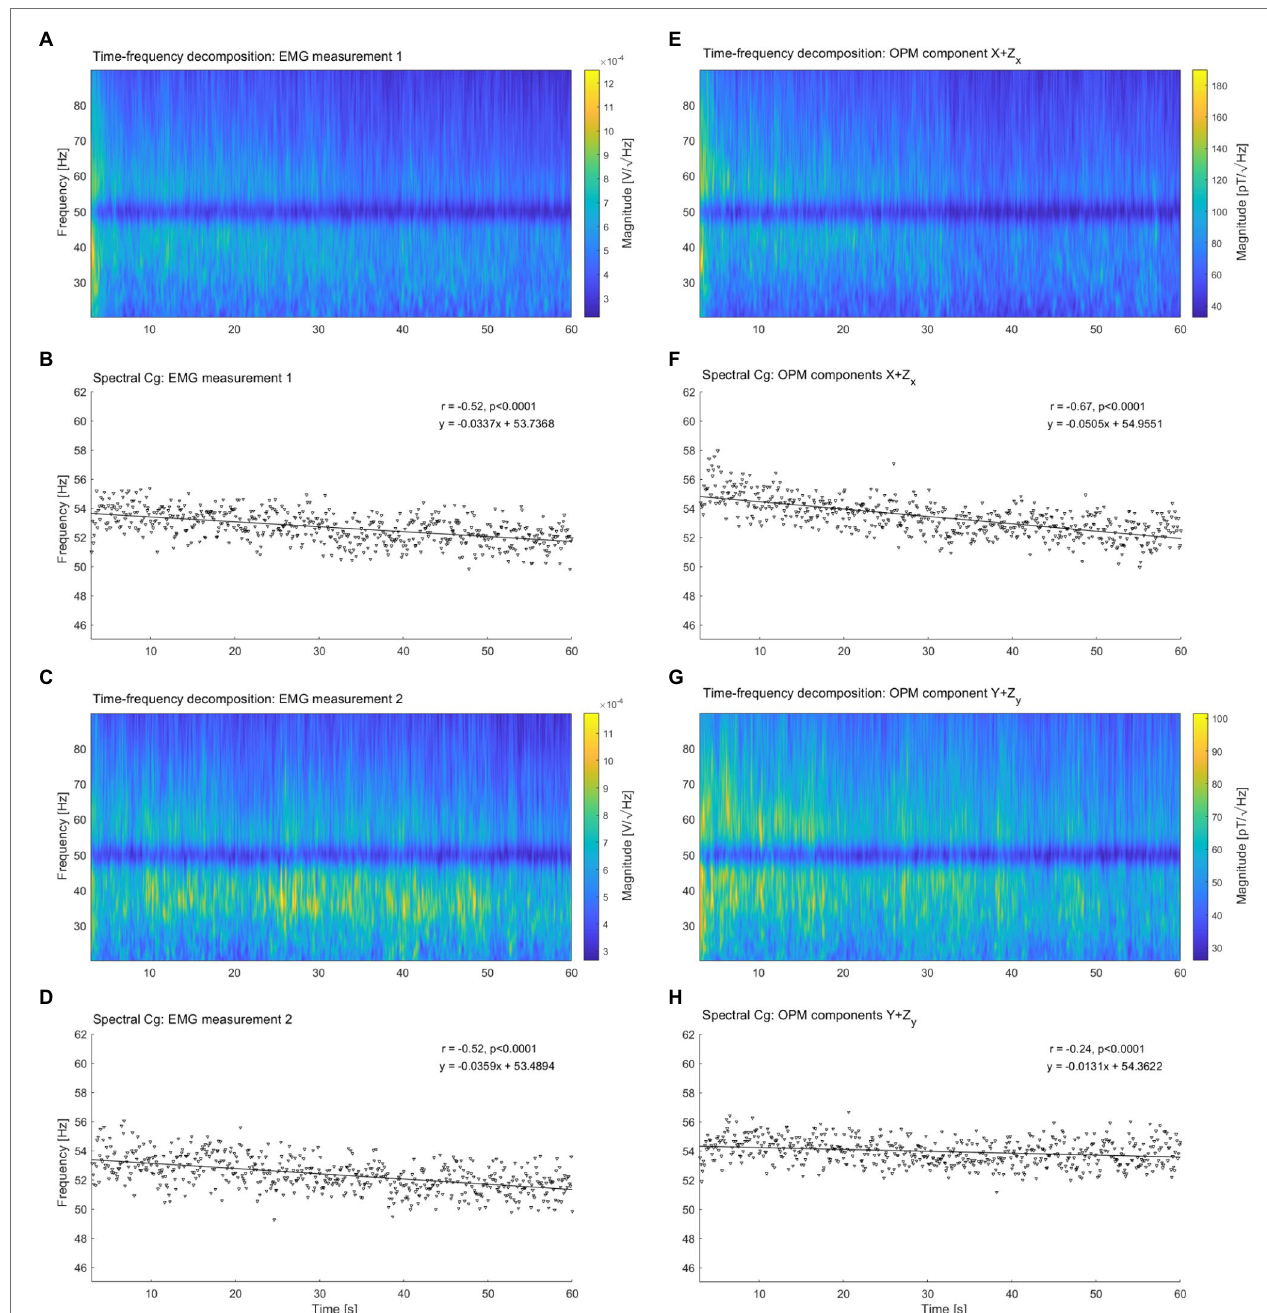
FIGURE 3 | Spectral decomposition and spectral center of gravity of surface electromyography (sEMG) and OPM-MMG summed components. (A,C) Spectral decomposition of the two electromyography (EMG) measurement. For the comparison, OPM orthogonal components X − Z X and Y − Z Y were summed using Pythagorean theorem. Spectral decomposition has been performed on the resultant components X + Z X (E) and Y + Z Y (G) . Line noise signal suppression visible at 50 Hz. (B,D) Decrease of the spectral center of gravity over time of the EMG signals. (F,H) Decrease of the spectral center of gravity over time for the OPM components. Pearson’s r, point of intercept, and slope of the regression line quantified the spectral shift of the magnetomyographic signal over